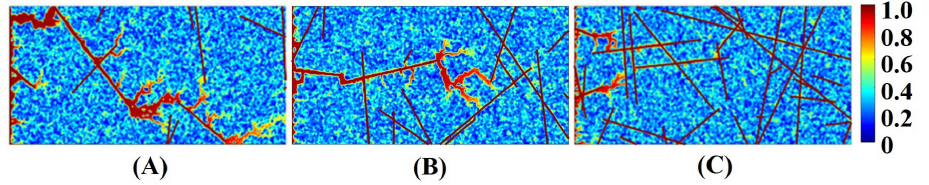
Figure 6. Influence of fracture density on wormhole structures, the number of fractures: ( A ) 12; ( B ) 17; ( C ) 30.